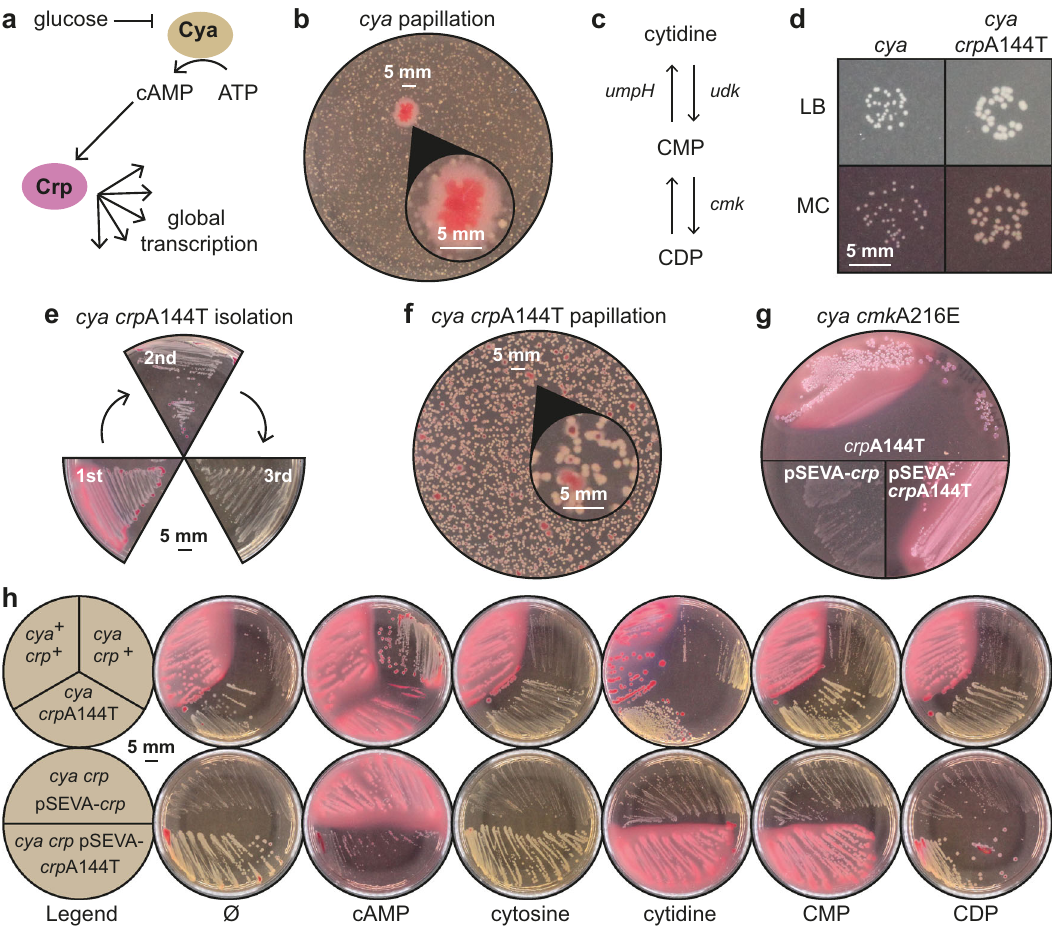
Fig. 1 Crp mutants point to a link between carbon catabolite repression and pyrimidine metabolism. a In the absence of glucose, the enzyme adenylate cyclase (Cya) produces cyclic adenosine monophosphate (cAMP) that binds and activates the global transcription factor cAMP Receptor Protein (Crp). b Escherichia coli cya mutants grow poorly on maltose MacConkey medium, but upon extended incubation mutant red (fermenting) papillae appear. c Synthesis and turnover of the pyrimidine nucleoside cytidine in E. coli . The cmk gene encodes cytidylate kinase that converts cytidine monophosphate (CMP) into cytidine diphosphate (CDP). CMP can also be converted into cytidine by the action of the ribonucleotide monophosphatase UmpH. Cytidine is phophorylated by the kinase Udk. d A majority of papillae obtain the mutation CrpA144T and the mutant exhibits a moderate increase in growth on both LB and maltose MacConkey agar plates (MC). e Mutants such as CrpA144T typically appear as red papillae because fermentation acidi fi es the medium, but often the fermentation phenotype gradually disappears upon re-streaking clones. f The crp A144T mutation accelerates mutant papillae formation that arise from almost every colony after few days. g A CmkA216E mutation frequently identi fi ed in papillae increases the activity of CrpA144T. This is shown in a cya crp A144T strain background (upper part of the plate) or in a cya crp background that is complemented with low-copy plasmids expressing either wildtype crp or the A144T mutant (lower part of plate). h Exogenously added cytosine nucleosides and nucleotides stimulate the activity of the CrpA144T mutant, both when expressed from the genome (pink single colonies with cytidine) and from a low-copy pSEVA plasmid (signi fi cant acidi fi cation both with cytidine and CMP). cAMP was included as a positive control and no supplement (Ø) served as a negative